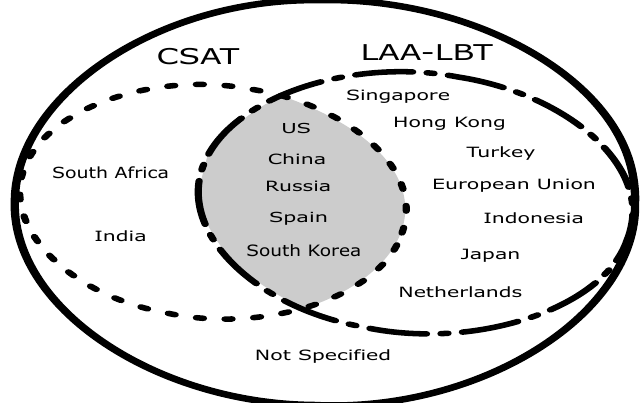
Figure 1. A region wise classification of trials and deployments of various channel access mechanisms for LTE’s operation in the unlicensed